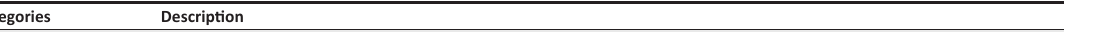
TABLE 2: Classification of the words associated with the stimulus word ‘entrepreneur’.